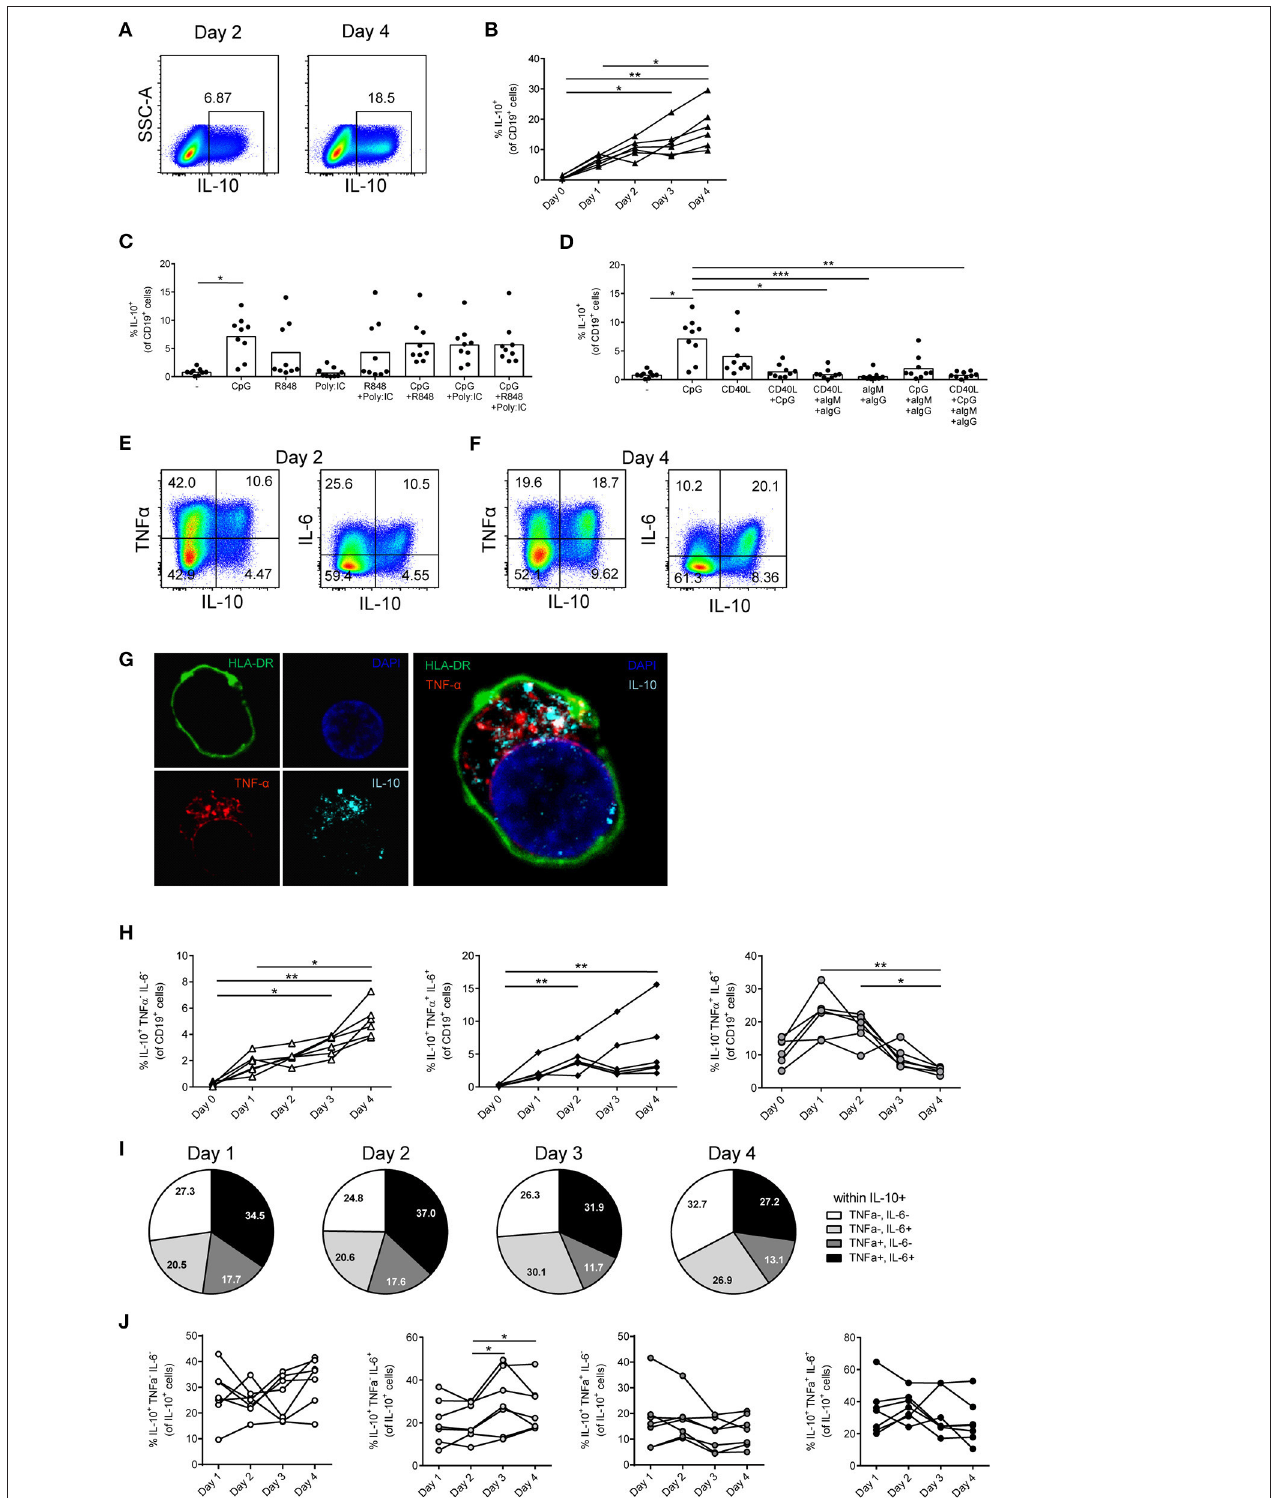
FIGURE 1 | Most in vitro -induced human IL-10 + B cells also express TNF α and/or IL-6. (A,B) Total CD19 + B cells were isolated from blood and stimulated with CpG (1.25 µ M) for 1–4 days followed by restimulation with PMA/Ionomycin/BFA (PIB) ( n = 6). Representative dot plots are shown in (A) . (C) Induction of IL-10 by